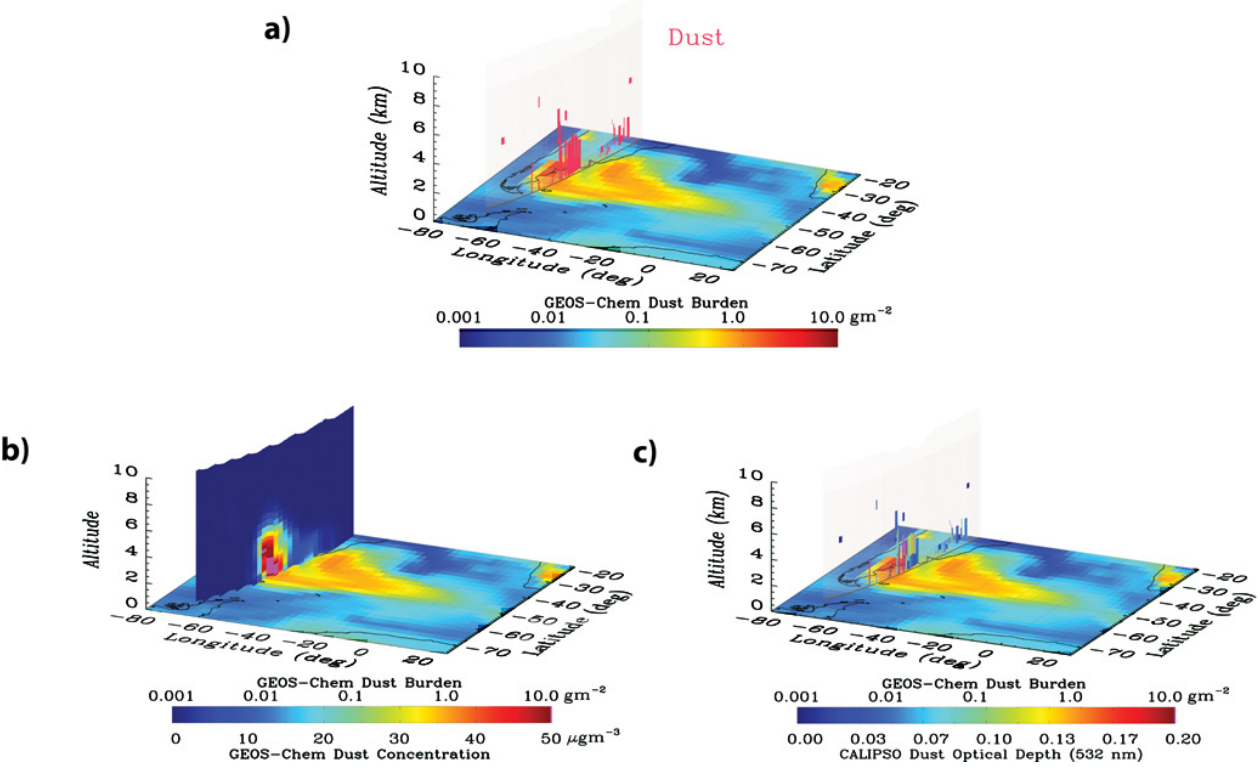
Fig. 3. The GEOS-Chem-predicted dust burden (gm − 2 ) for 23 January 2009 (the background image) with overlaid vertical swaths of (a) CALIPSO retrievals of dust aerosol layers, (b) model-predicted vertical cross-section of dust concentration (µgm − 3 ) along the CALIPSO orbit track and (c) CALIPSO dust layer AOD at 532nm. Modeled vertical cross-section calculations are conducted along the CALIPSO orbital track beginning at 04:28:59UTC on 23 January 2009